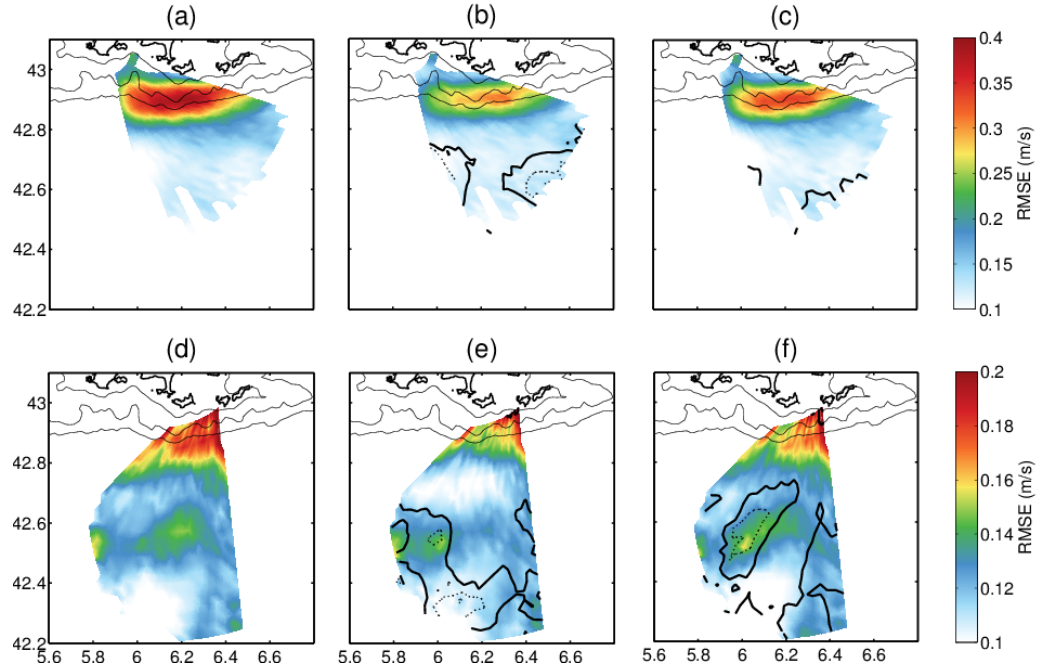
Figure 9. Spatial distributions of (a) Er b (y pey ) , (b) Er a (y pey ) for WindReal and (c) Er a (y pey ) for ObcReal (respectively d , e , f for y ben ). 1 is indicated by contour lines and only 0ms − 1 (bold black lines) and negatives ( − 0.02 and − 0.01ms − 1 , dashed black lines) values are shown. Colorbars differ for PEY and BEN. The 100, 1000 and 2000m isobaths are drawn (black thin